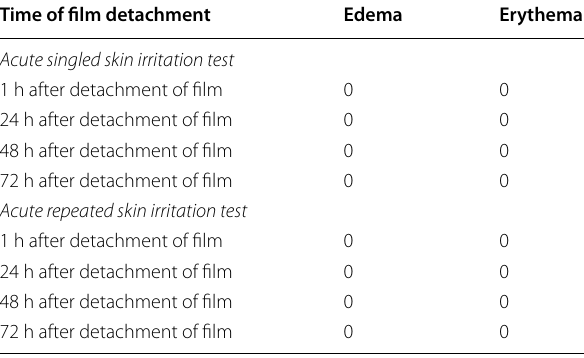
Table 9 Scoring for skin sensitivity test Time of film detachment Edema Erythema